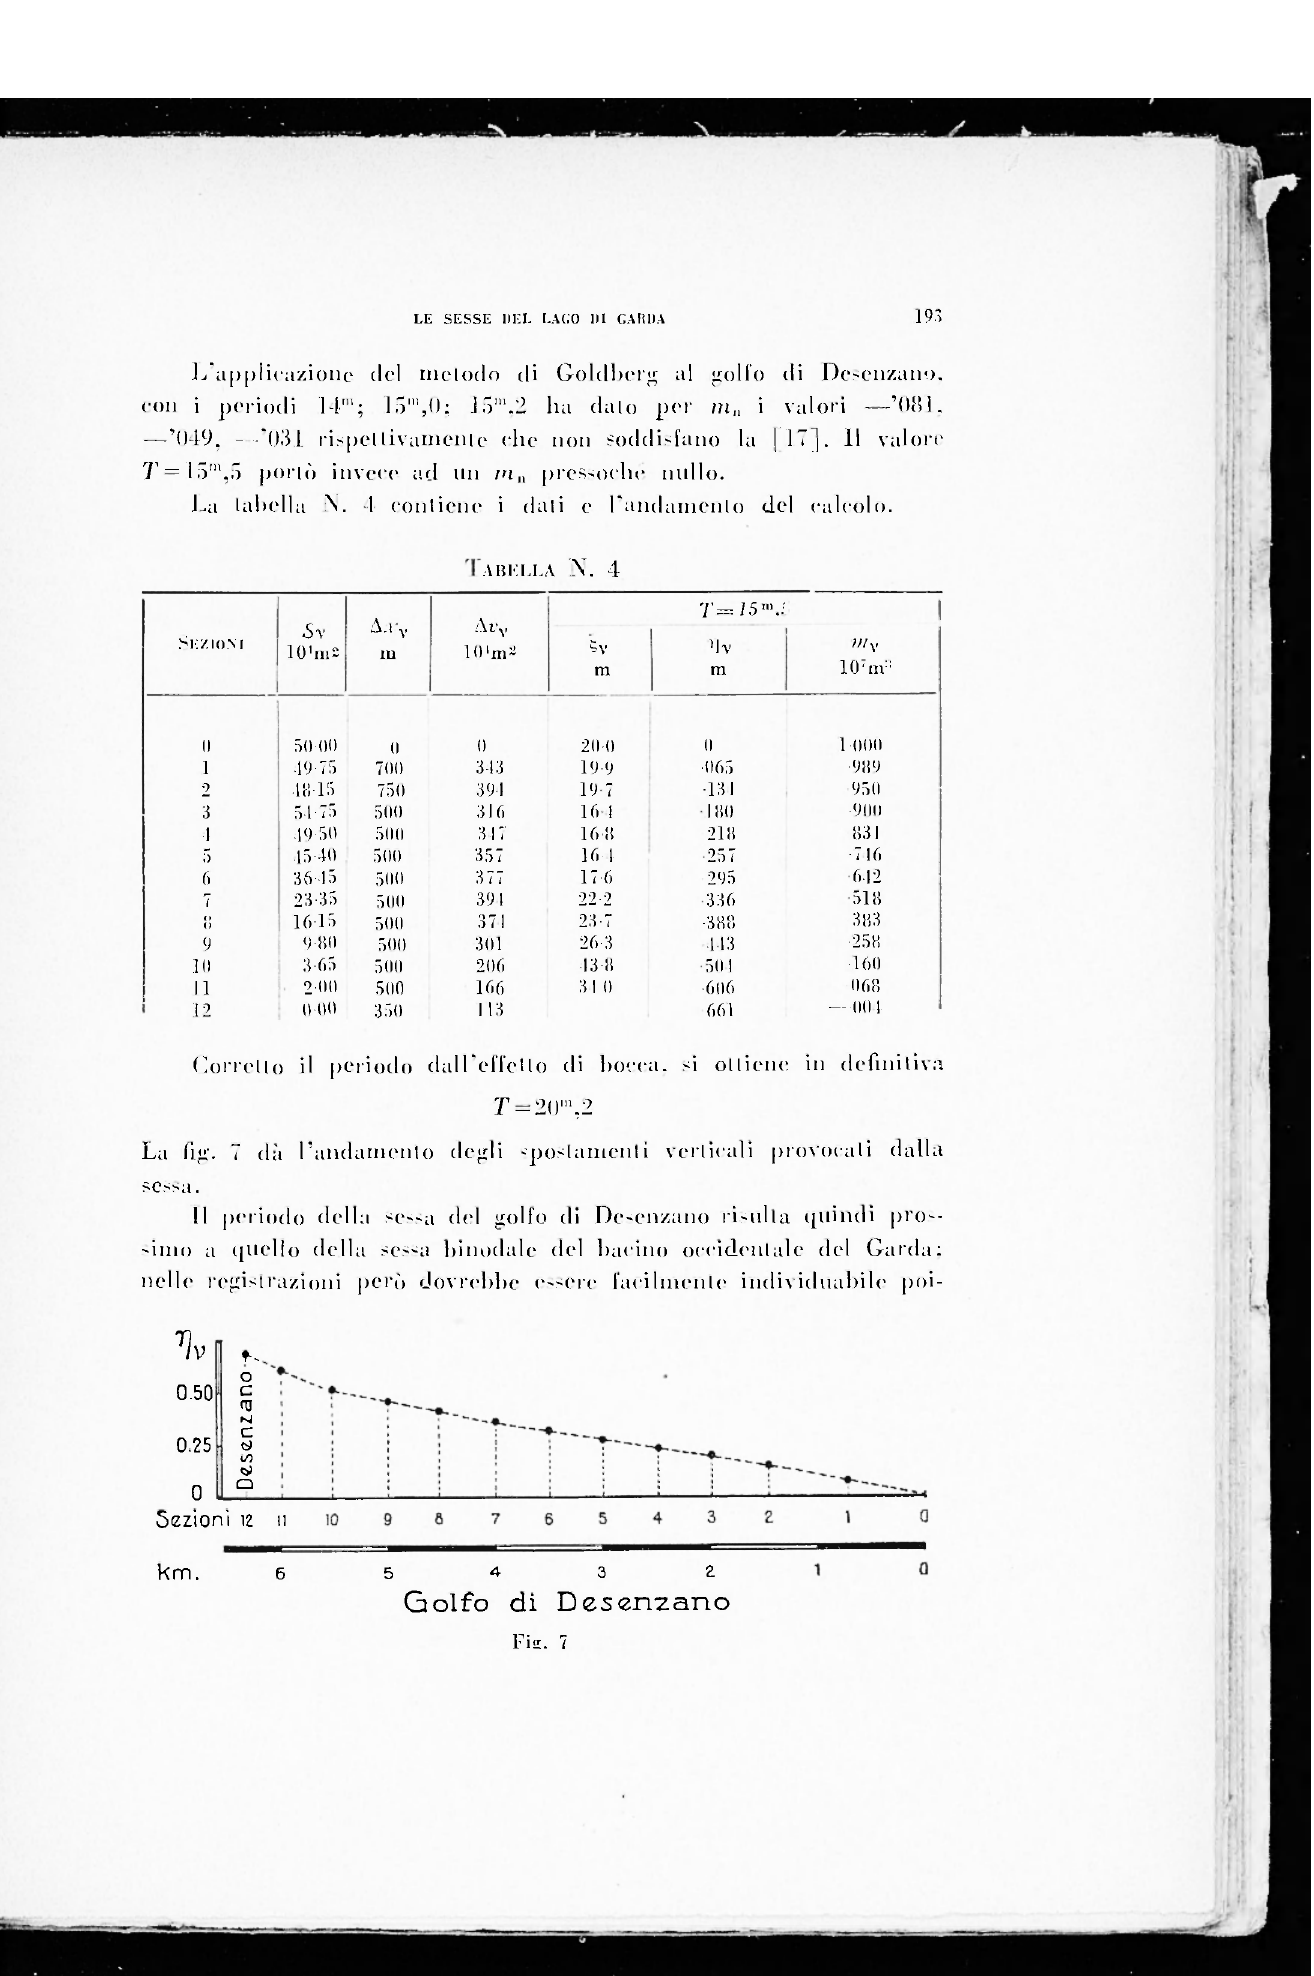
La fig. 7 dà l'andamento degli spostamenti verticali provocati dalla